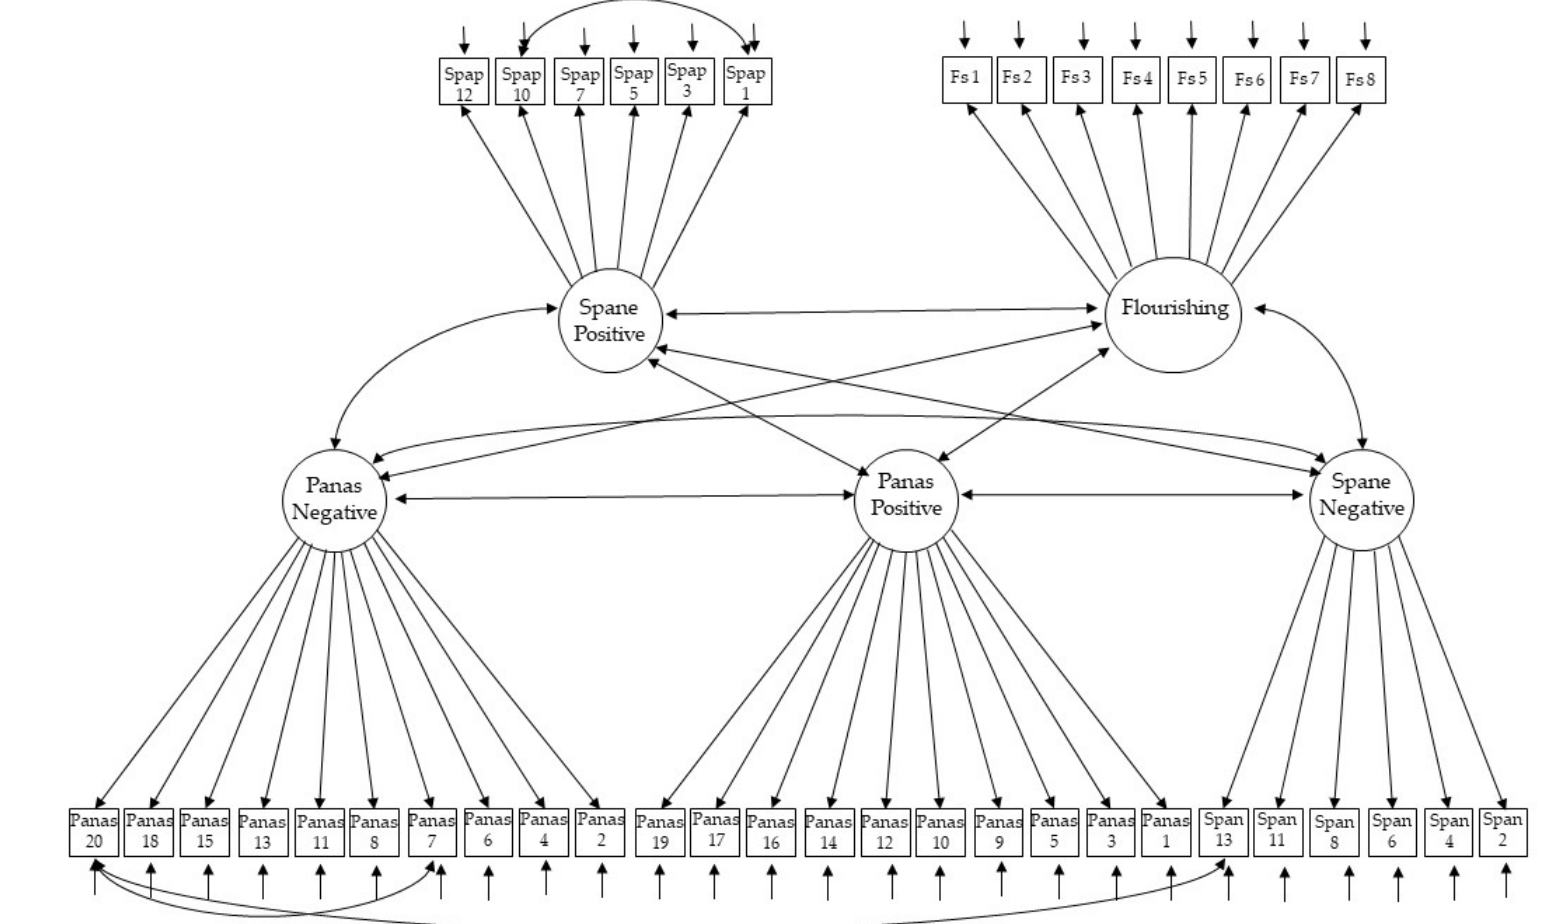
Figure 2. Path diagram for the convergent validity model. Panas: Positive and Negative Affect Schedule; Spane: Scale of Positive and Negative Experience.